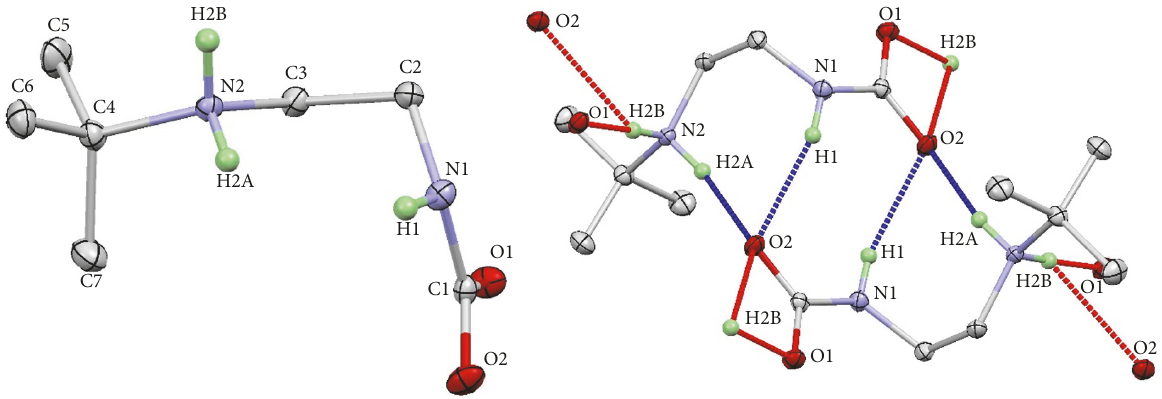
Figure 1: Molecular structure of t BuN(H) 2 C 2 H 4 N(H)CO 2 ( 1 , left) forming dimeric units and an extended structure through H-bonding (right). Thermal ellipsoids set at 50% probability. Hydrogen atoms except for those attached to N atoms are omitted for clarity. Selected bond lengths (˚A) and angles ( ∘ ): O1-C1 1.267(1), O2-C1 1.277(1), N1-C1 1.400(1), N1-C2 1.464(1), O1-C1 O2 123.98(8), C1-N1-C2 120.32(7).